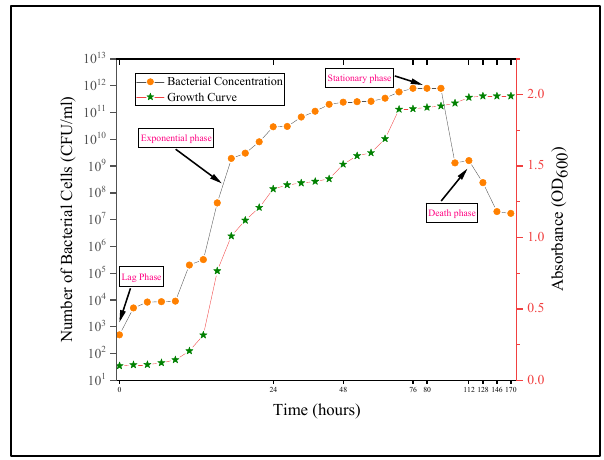
Figure 1 . Microbial life ‐ cycle assessment .